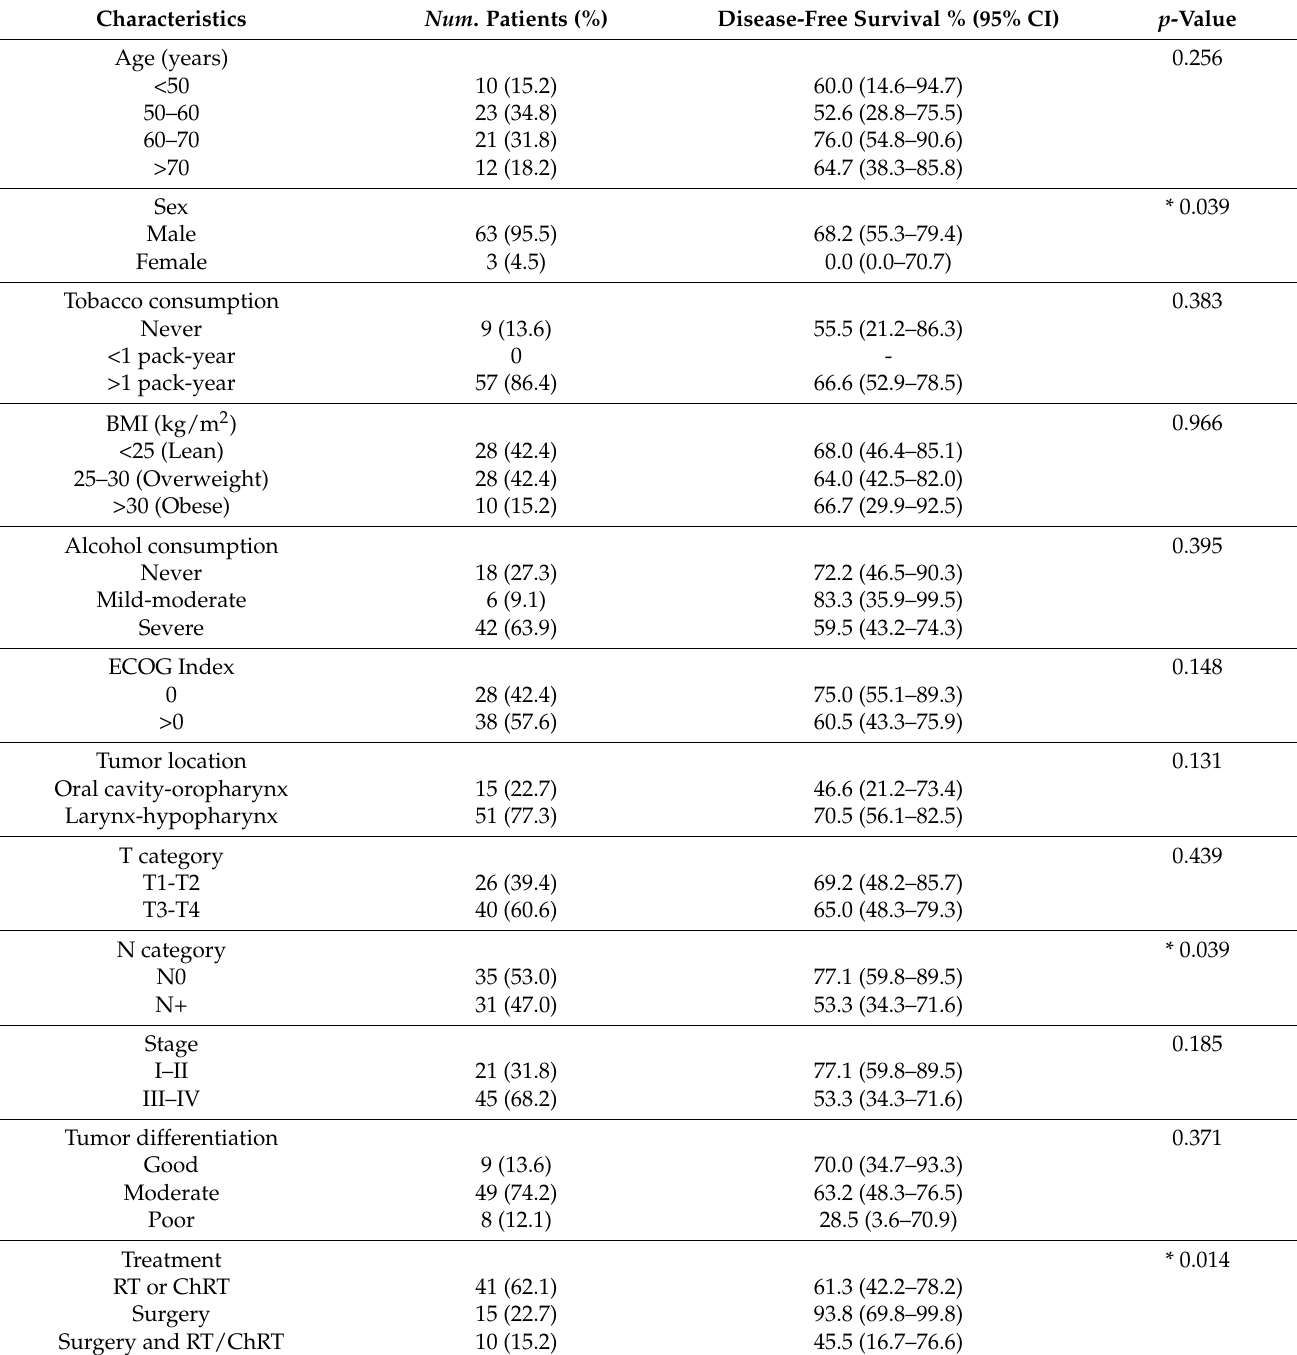
Table 1. Characteristics of the Study Cohort Including Univariate Analysis Data of Locoregional Disease-Free Survival.